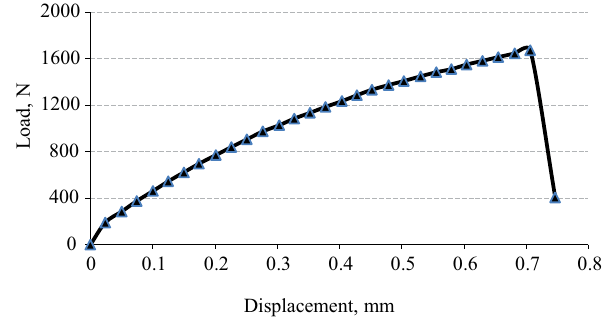
Figure 5. Loading-displacement